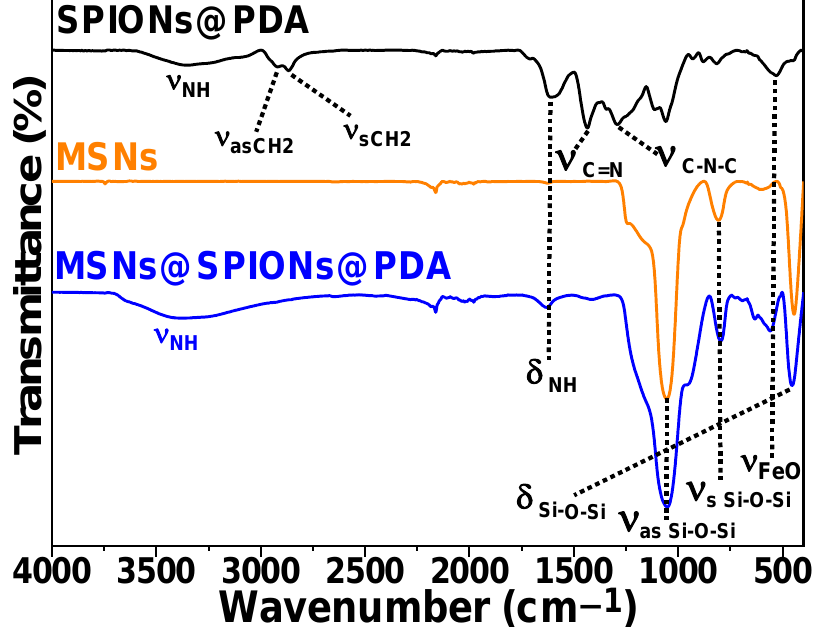
Figure 5. FTIR spectra of SPIONs@PDA (black pattern), MSNs (orange pattern) and MSNs@SPI- ONs@PDA (blue pattern).